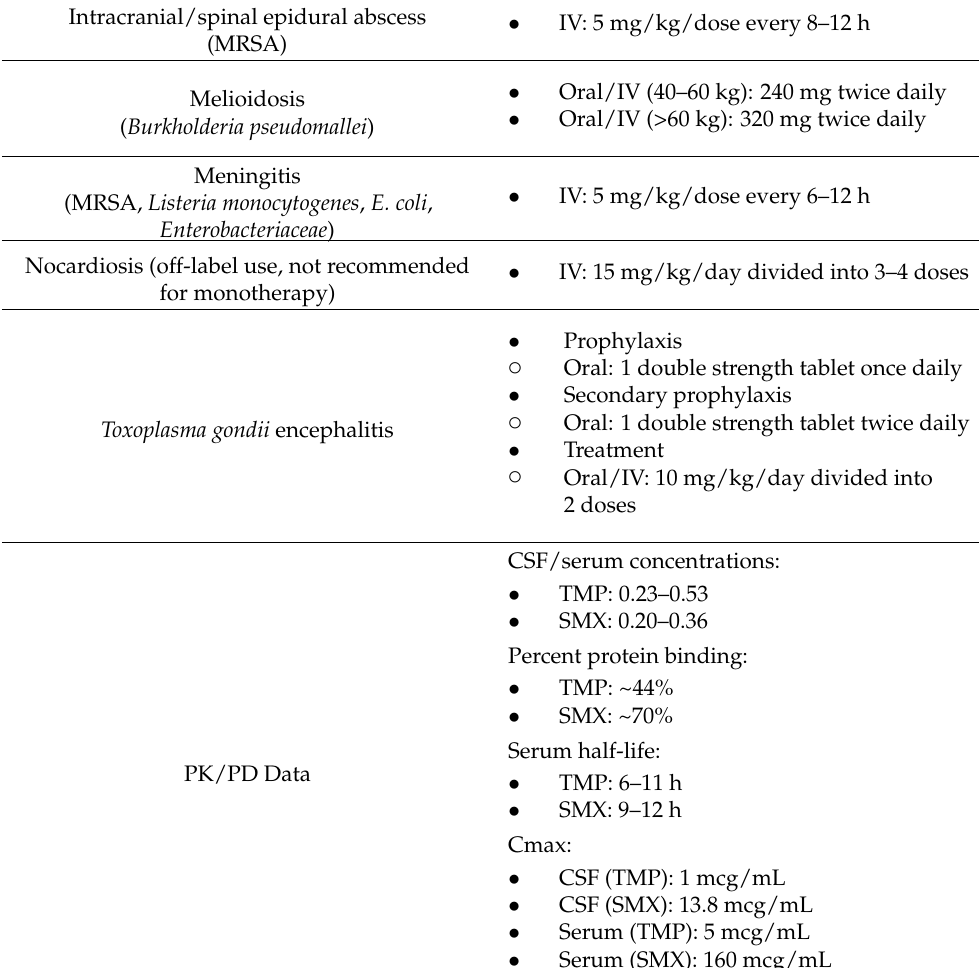
Table 7. Sulfamethoxazole/Trimethoprim dosing by indication/targeted organisms and PK/PD data.